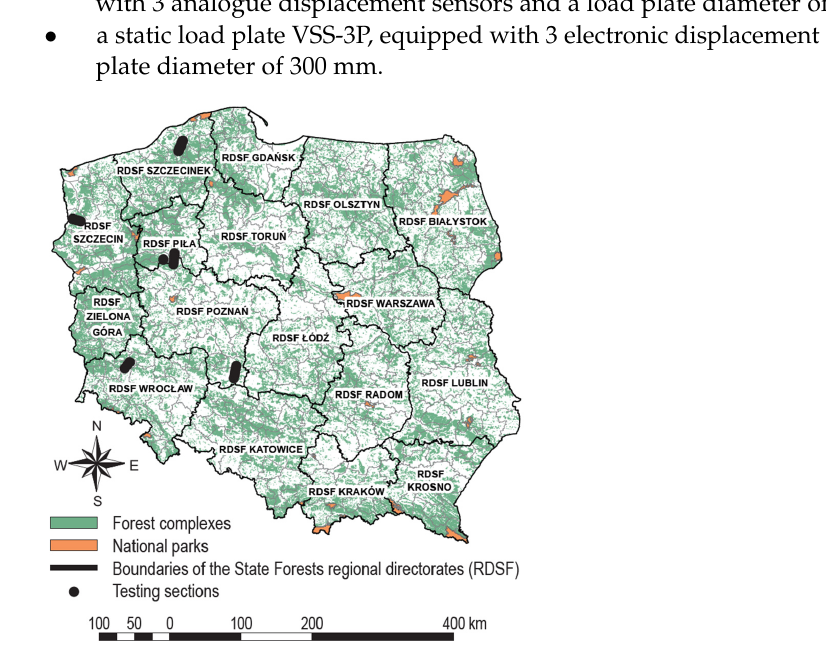
Figure 1. Locations of the test road sections on the afforestation map of Poland (adapted from The State Forests in Figures 2018 [55] with permission from State Forests Information Centre, Warsaw, Poland, 2022.